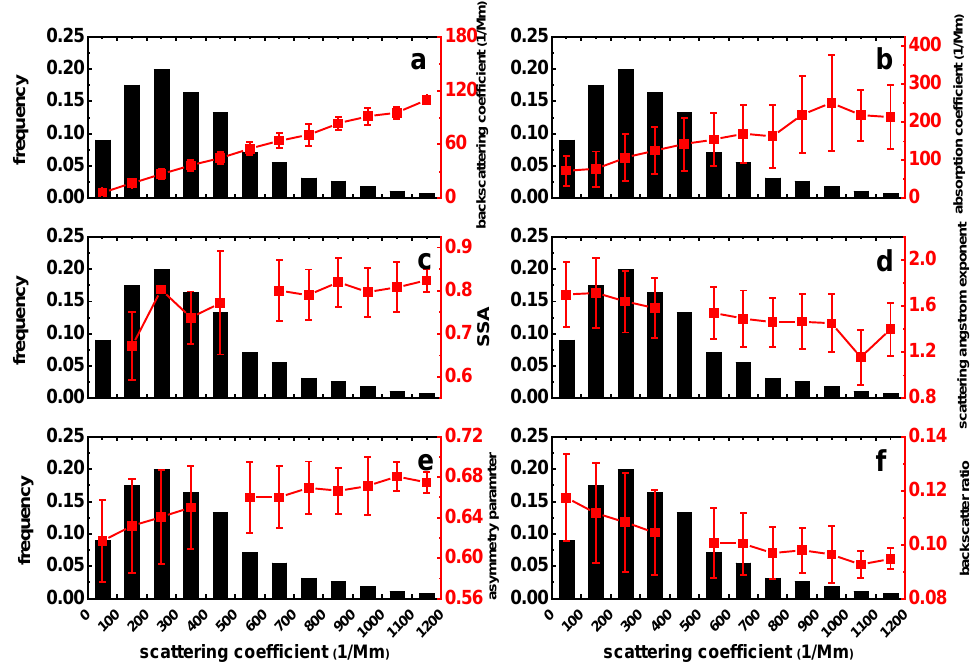
Figure 4. Correlation between the frequency distribution of aerosol scattering coe ffi cients ( σ s ) and ( a ) aerosol backscattering coe ffi cients ( β s ) at 550 nm; ( b ) absorption coe ffi cients ( σ ab ) at 550 nm; ( c ) single scattering albedo (SSA) at 550 nm; ( d ) scattering Ångström exponents ( α s ) at 550 nm; ( e ) asymmetry factor (g) at 550 nm; ( f ) backscatter ratio (b) at 550 nm.